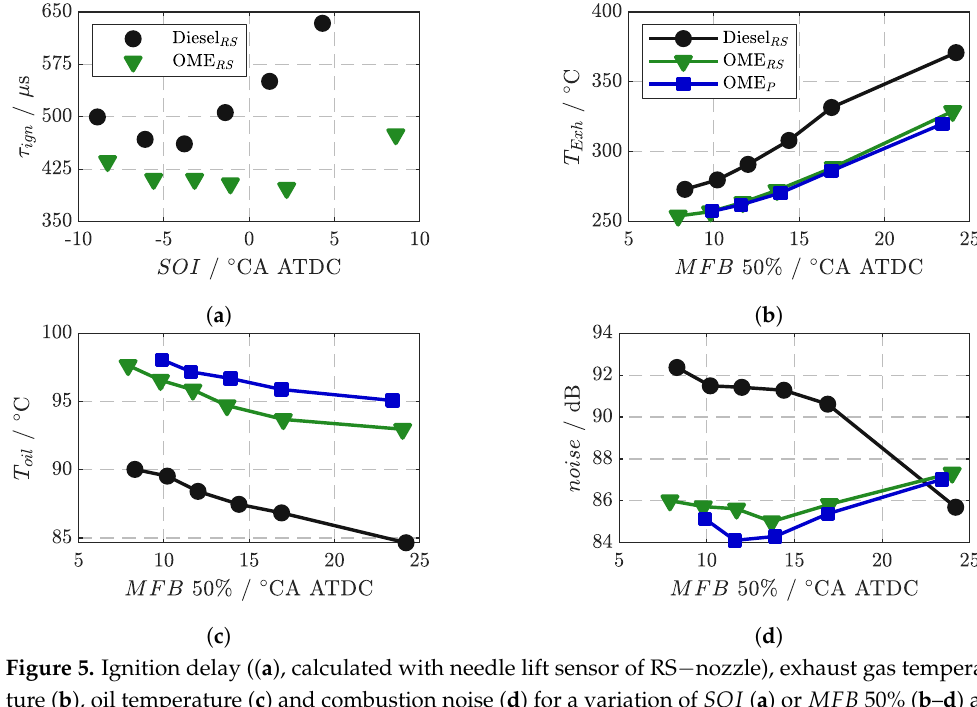
Figure 5. Ignition delay (( a ), calculated with needle lift sensor of RS − nozzle), exhaust gas tempera- ture ( b ), oil temperature ( c ) and combustion noise ( d ) for a variation of SOI ( a ) or MFB 50% ( b – d ) at OP 1 ( n = 2600 1/min, BMEP = 2.2 bar) for two different nozzles in